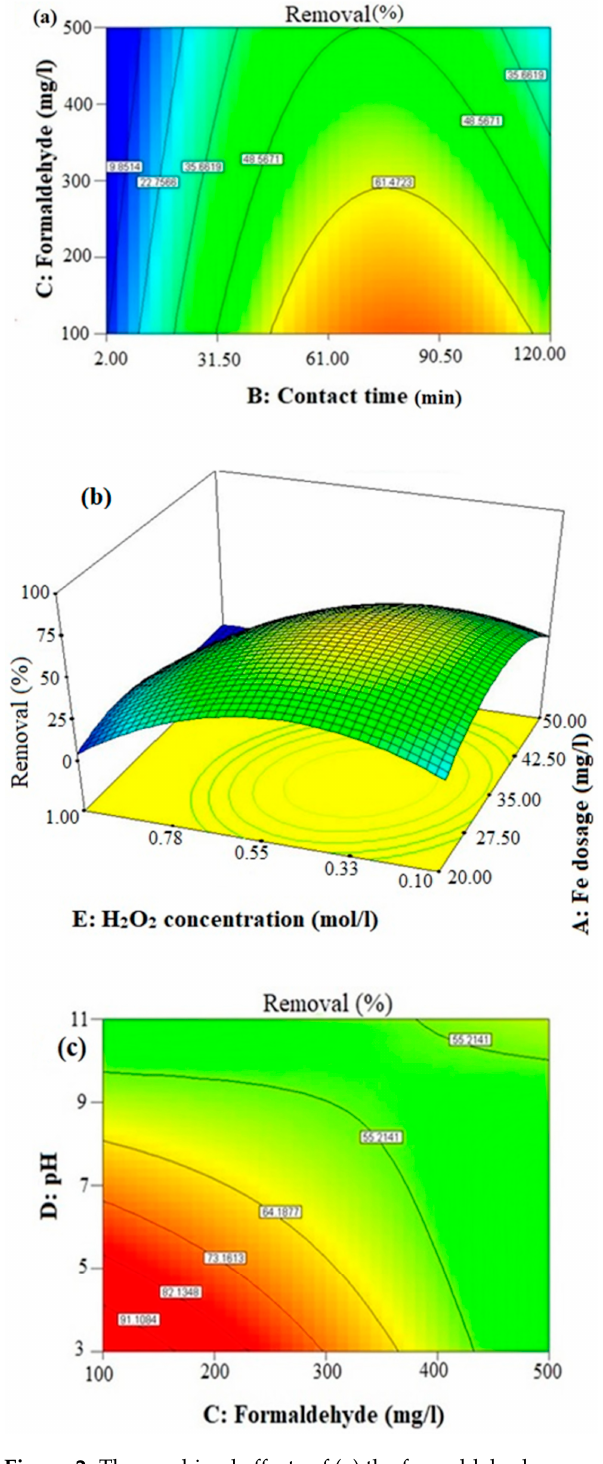
Figure 2. The combined effects of ( a ) the formaldehyde concentration and contact time, ( b ) Fe dosage and H 2 O 2 concentration and ( c ) pH and initial formaldehyde concentration on the elimination of formaldehyde from wastewater in the Fenton